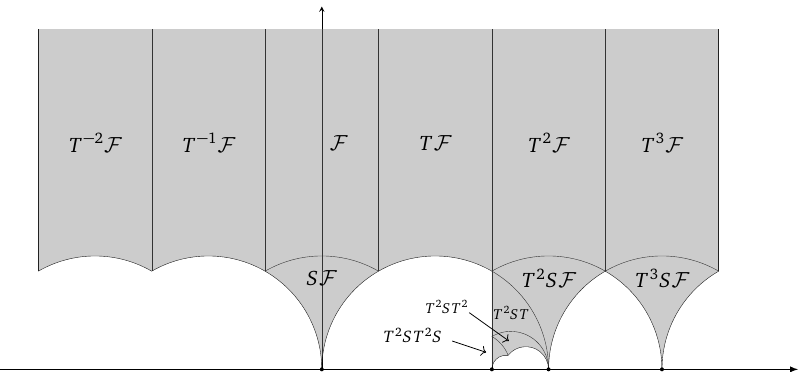
Figure 18: Different fundamental domain for Γ 0 ( 9 ) , with I